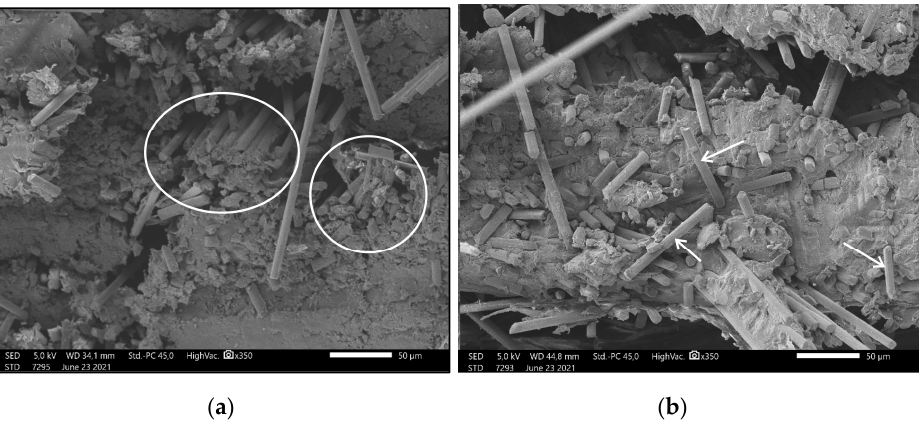
Figure 11. ( a ) Image showing the carbon fibers in the test specimen broken in one step; the fibers have the same length and orientation (white circle). ( b ) Image taken from the broken surface of the specimen after 20,000 flexural cycles. In this case, the carbon fibers have random orientation, and they are fragmented into small pieces (white arrows). The magnification was 350× in both cases .